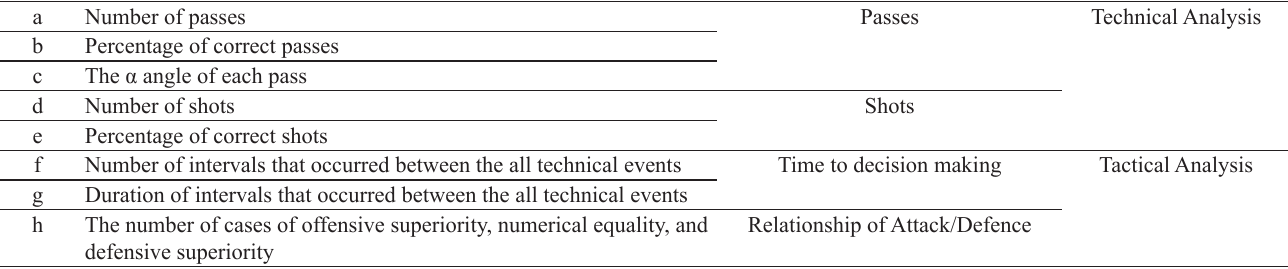
Table 1. Variables analyzed.